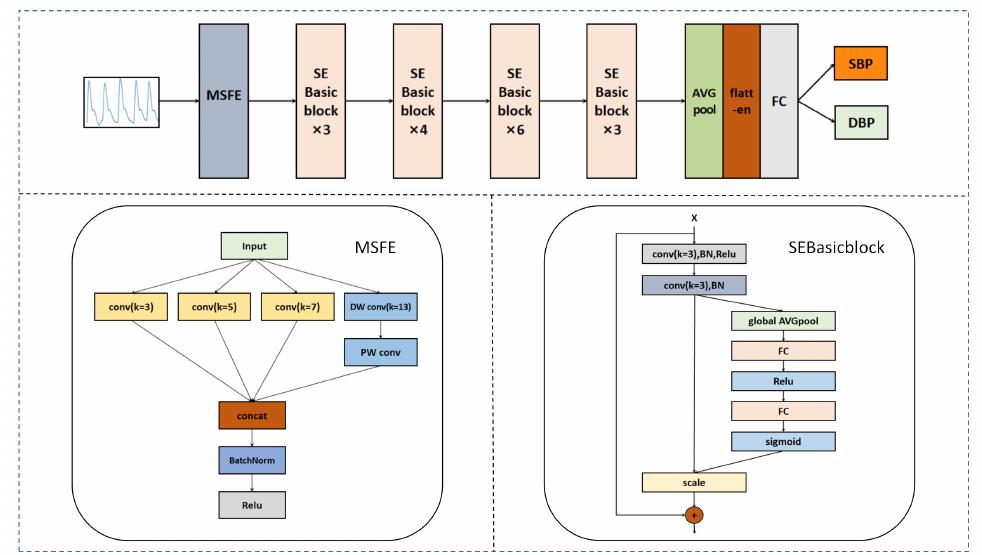
Figure 2. The framework of